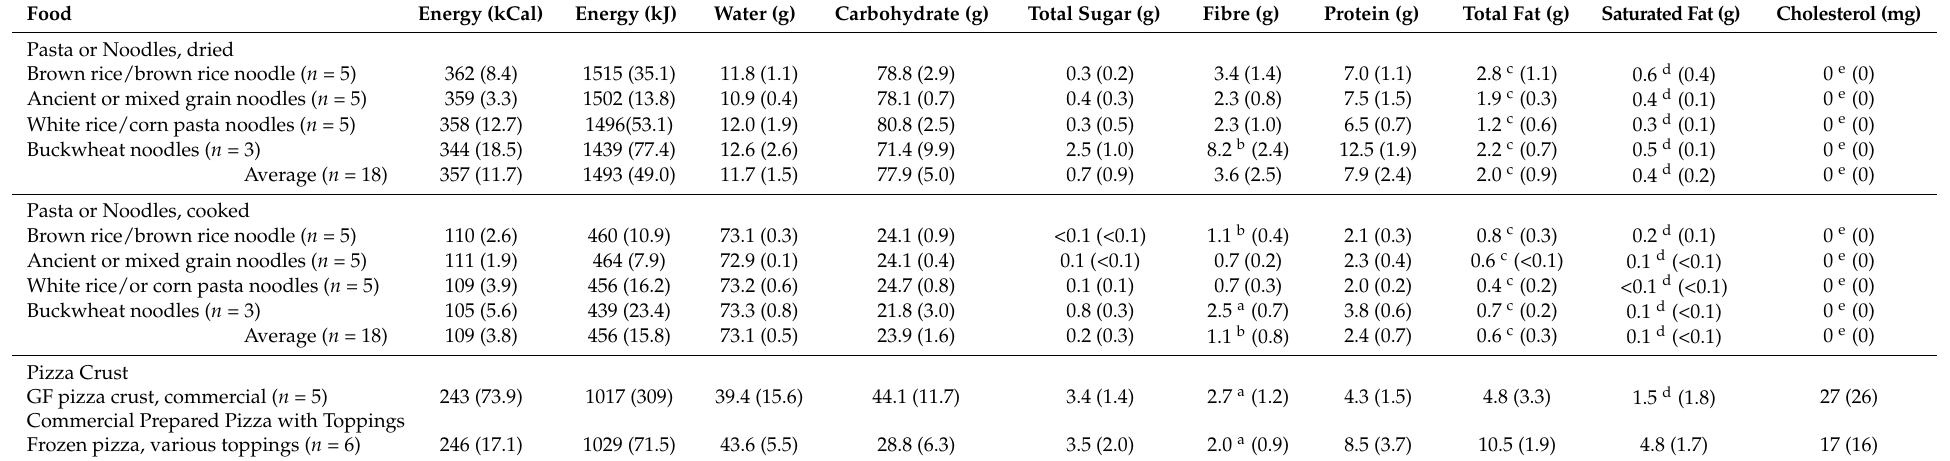
Table 2. Energy and macronutrient content of gluten-free pastas and pizzas per 100 g